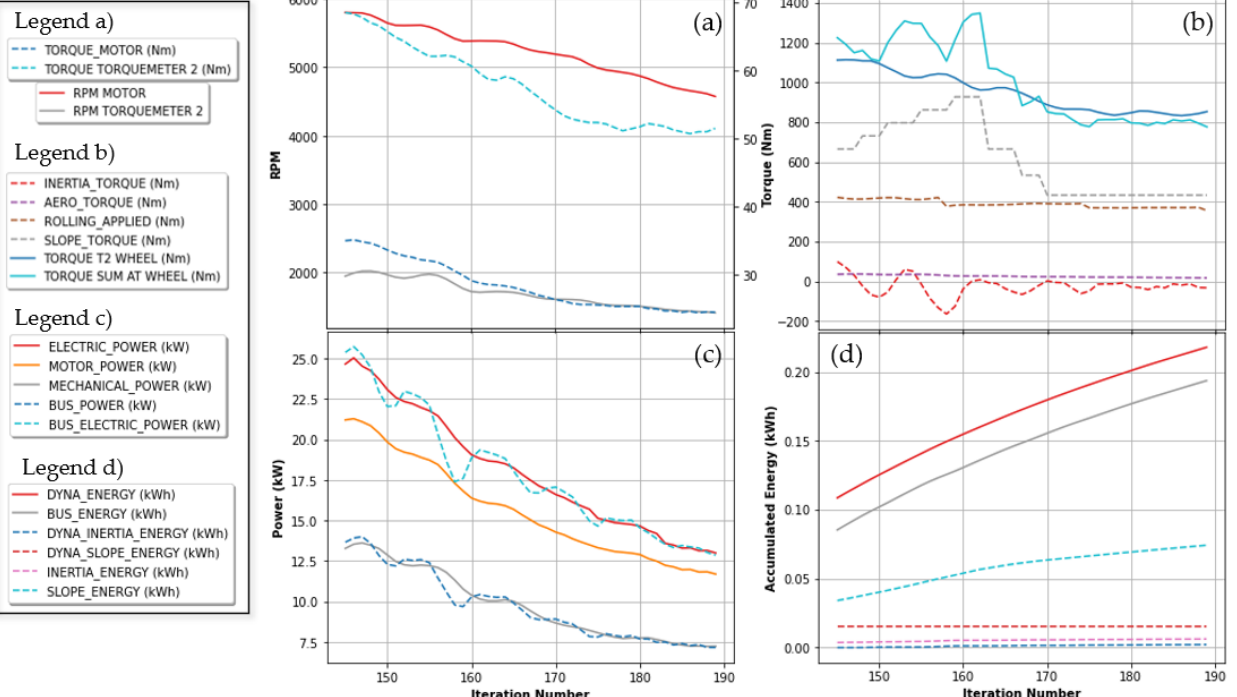
Figure 15. Accelerating uphill changing section. ( a ) Torques and RPMs measured by dynamometer sensors. ( b ) Torques values per origin force. ( c ) Dynamometer power and equivalent bus power. ( d ) Accumulated energy for the whole route.